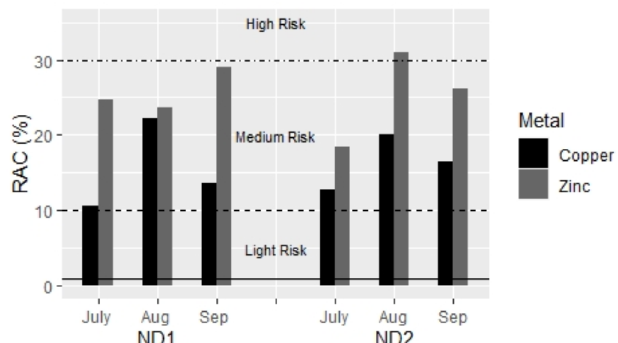
Figure 7. Risk Assessment Code (RAC) for Cu and Zinc in sediment samples from the HCW, analyzed by sequential